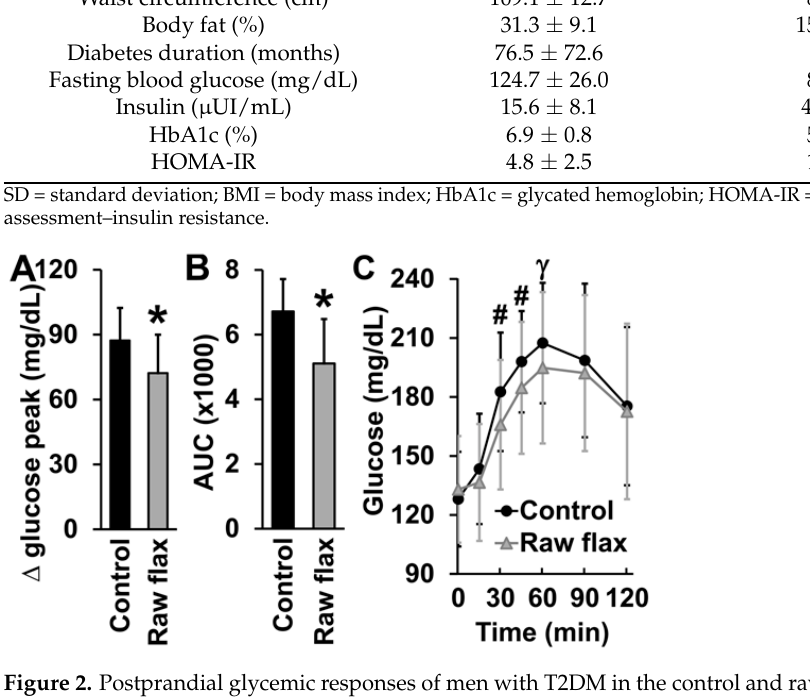
Figure 2. Postprandial glycemic responses of men with T2DM in the control and raw flaxseed groups. ( A ) Glucose peak rise in men with T2DM after ingesting a breakfast containing 50 g of complex carbohydrates either without (control) or with (flax) prior intake of 15 g of raw flaxseed, ( B ) area under the glycemic curve (AUC; mg/dL/min), and ( C ) glycemic curve. * p ≤ 0.001 vs. control; # p = 0.03 vs. control; γ p = 0.072 vs. control.